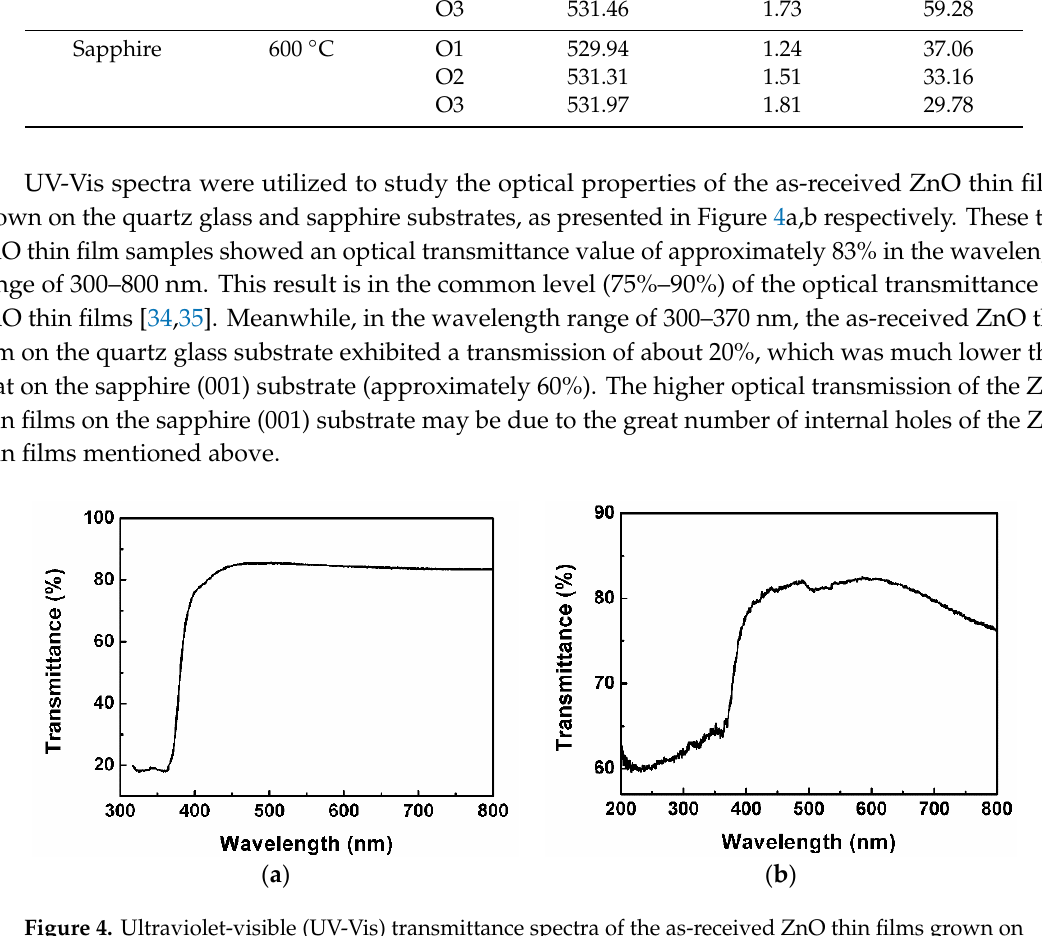
Figure 5. ( αhν ) 2 vs. photon energy spectra for the ZnO thin films grown on the ( a ) quartz glass and ( b ) sapphire (001) substrates, respectively.